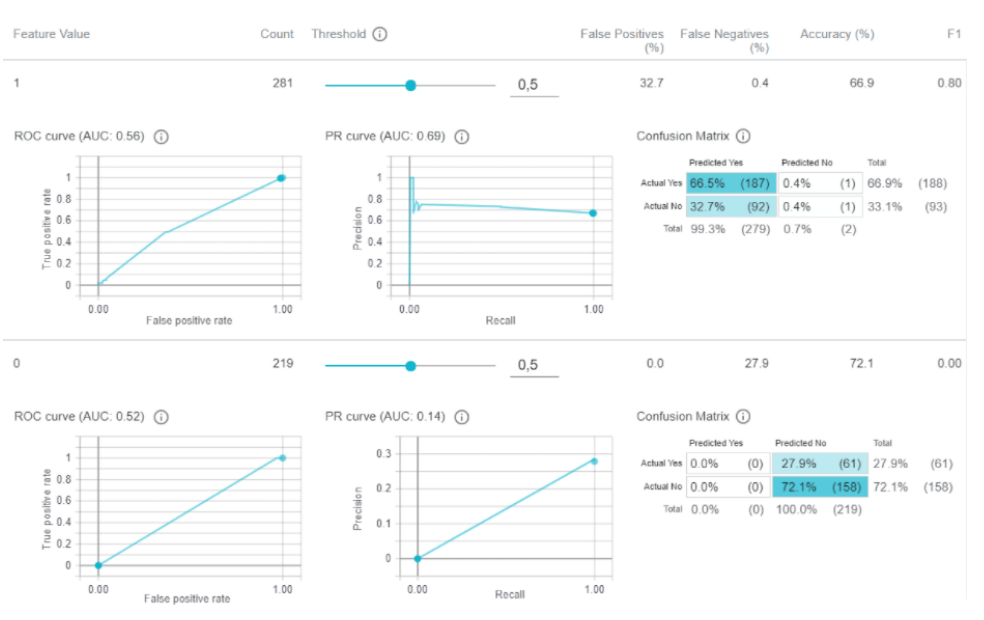
Figure 7. Bias analysis for the social welfare program attribute in the M1G1-UTU